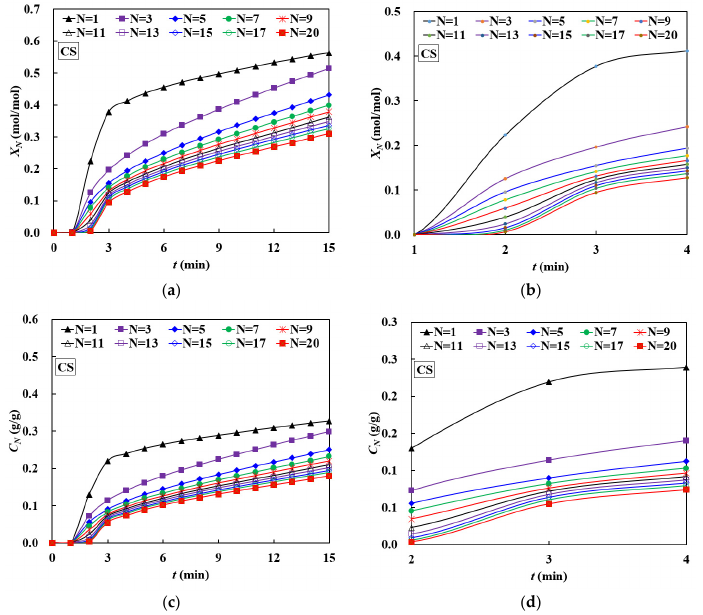
Figure 6. CO 2 capture characteristics of CS during different cycle number: ( a ) relationship between X N and N; ( b ) zoom of ( a ); ( c ) relationship between C N and N; ( d ) zoom of ( c ). From Figure 5, it can be seen that X 1 and X 20 for RES were 0.672 mol/mol and 0.192 mol/mol, respectively, which indicates a 71.43% decrease from Cycle 1 to Cycle 20. Figure 7 shows that the reactivity of RES was significantly higher during Cycle 1. At a reaction time of 3 min, the values of X N and C N were 0.334 mol/mol and 0.223 g/g during Cycle 1; however, the corresponding values for Cycle 3 had decreased considerably to 0.084 mol/mol 0.056 g/g. As the cycle number increased, the degree of carbonation at the same reaction time point decreased gradually. Except for the first two cycles, there were few changes in the XN values for RES after 3 min of reaction in each cycle.